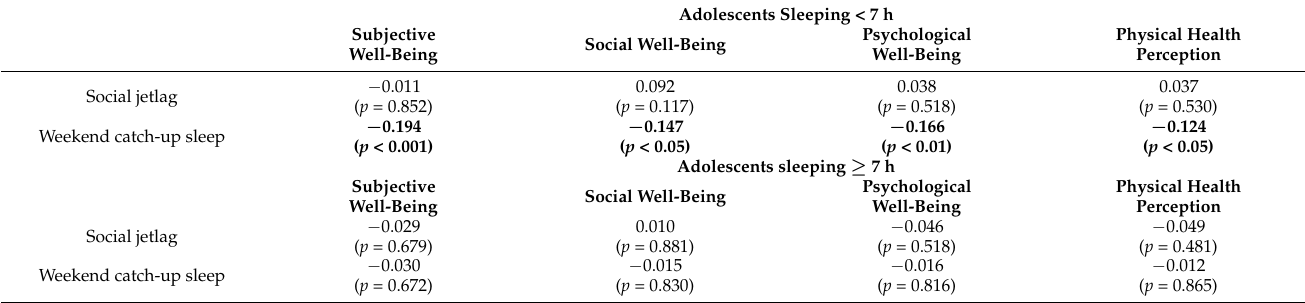
Table 1. Pearson’s correlation values (with the p -value within brackets) between social jetlag and weekend catch-up sleep on one side and subjective, social, and psychological well-being, and physical health perception on the other, separately for the sleep duration group. Significant correlations are highlighted in